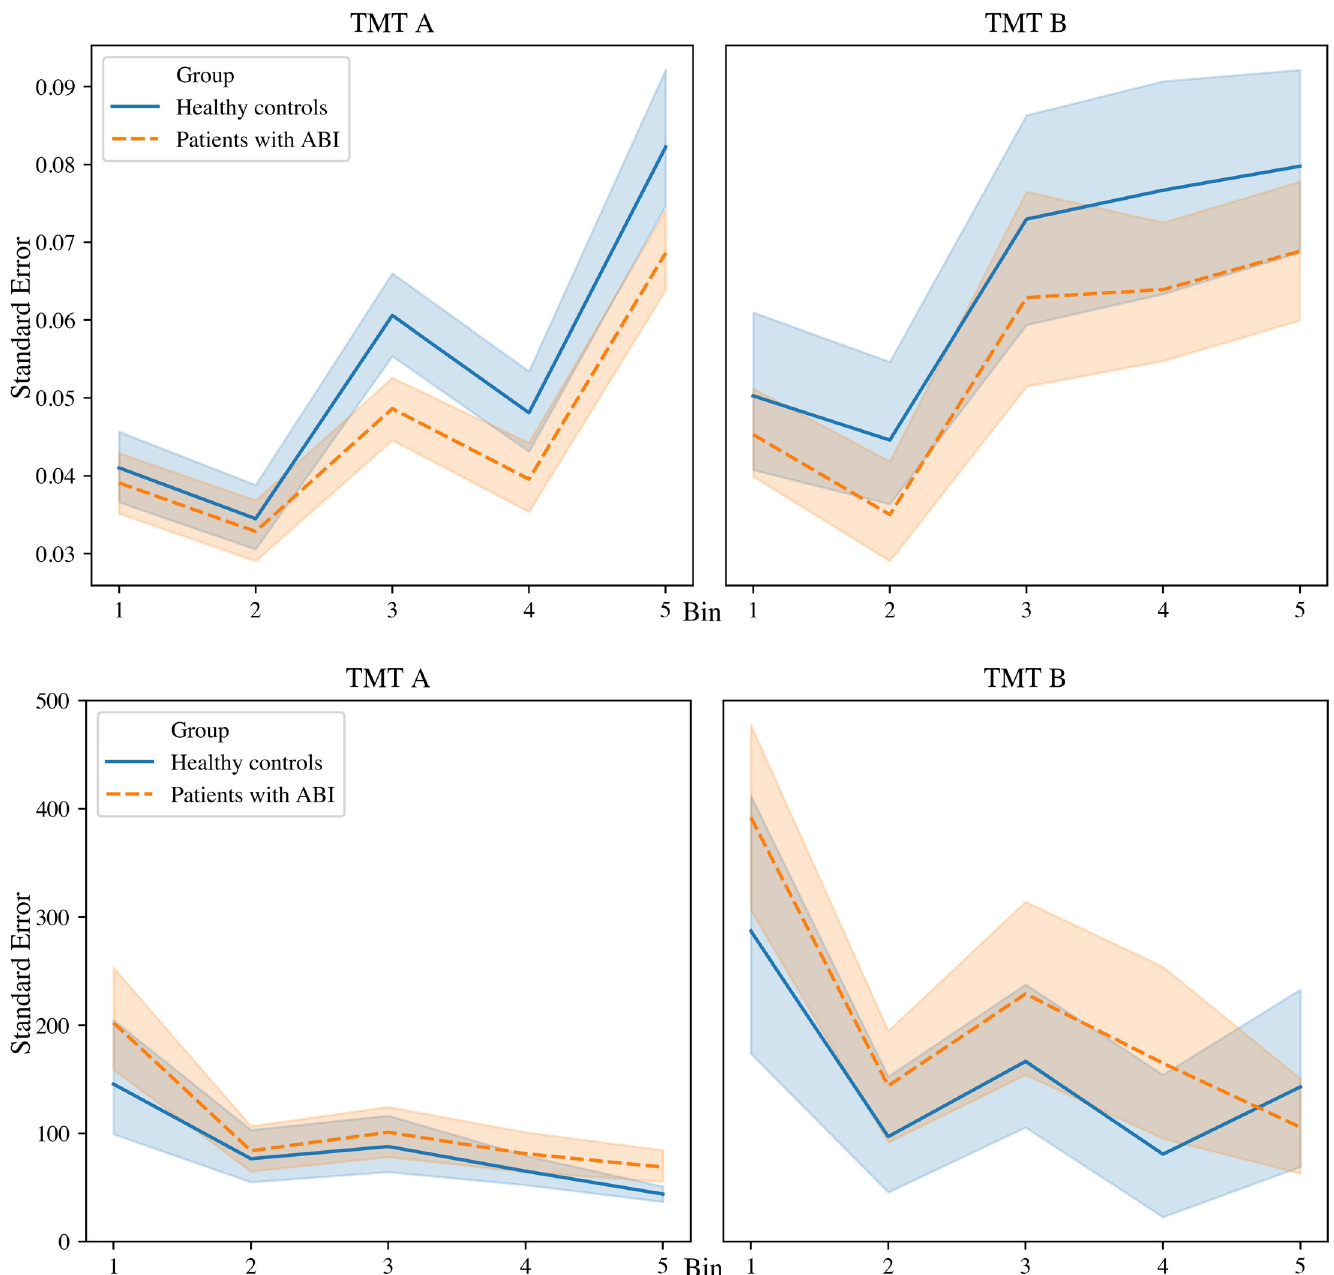
Fig 3. a. Performance stability in drawing speed on the TMT (part A and B) at group level. Each stage was divided into 5 bins of 5 targets (horizontal axis). The standard error is depicted on the vertical axis. The performance stability in drawing speed of patients and healthy controls was comparable. b. Performance stability in “thinking/searching time” (with time spent within a target as outcome measures) on the TMT (part A and B) at group level. Each stage was divided into 5 bins of 5 targets (horizontal axis). The standard error is depicted on the vertical axis. Patients fluctuated significantly more in “thinking/searching time” compared to healthy